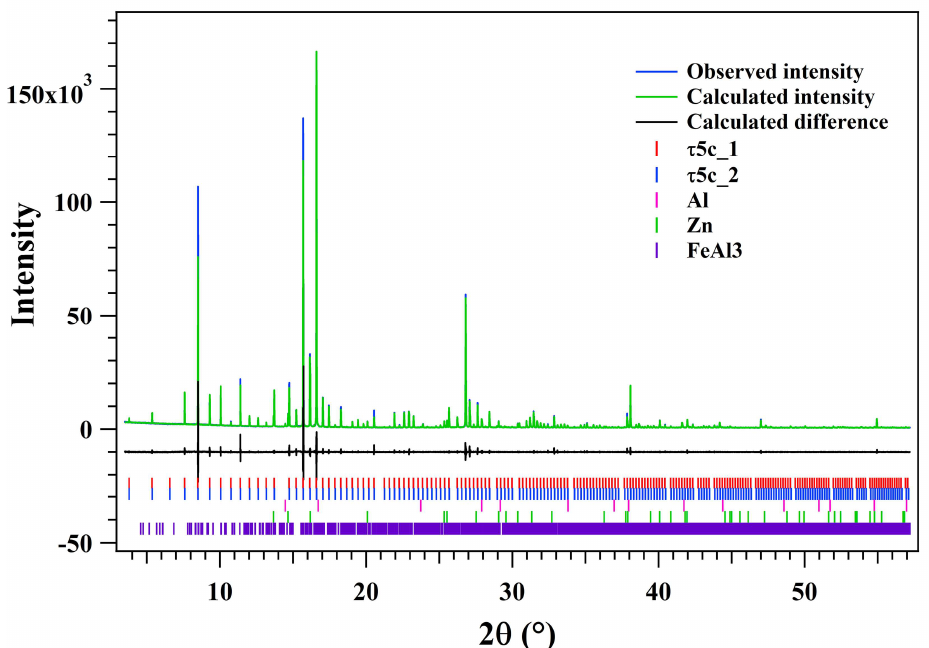
Figure 3. Typical one-dimensional XRD pattern for the dross powder at 30 ◦ C. The observed intensity is presented in blue. The calculated intensity after Pawley refinement is shown in green. The fitting difference (black curve) and the phase index (vertical line markers) are shown in the figure as well. The fitting difference curve is offset for clarity.